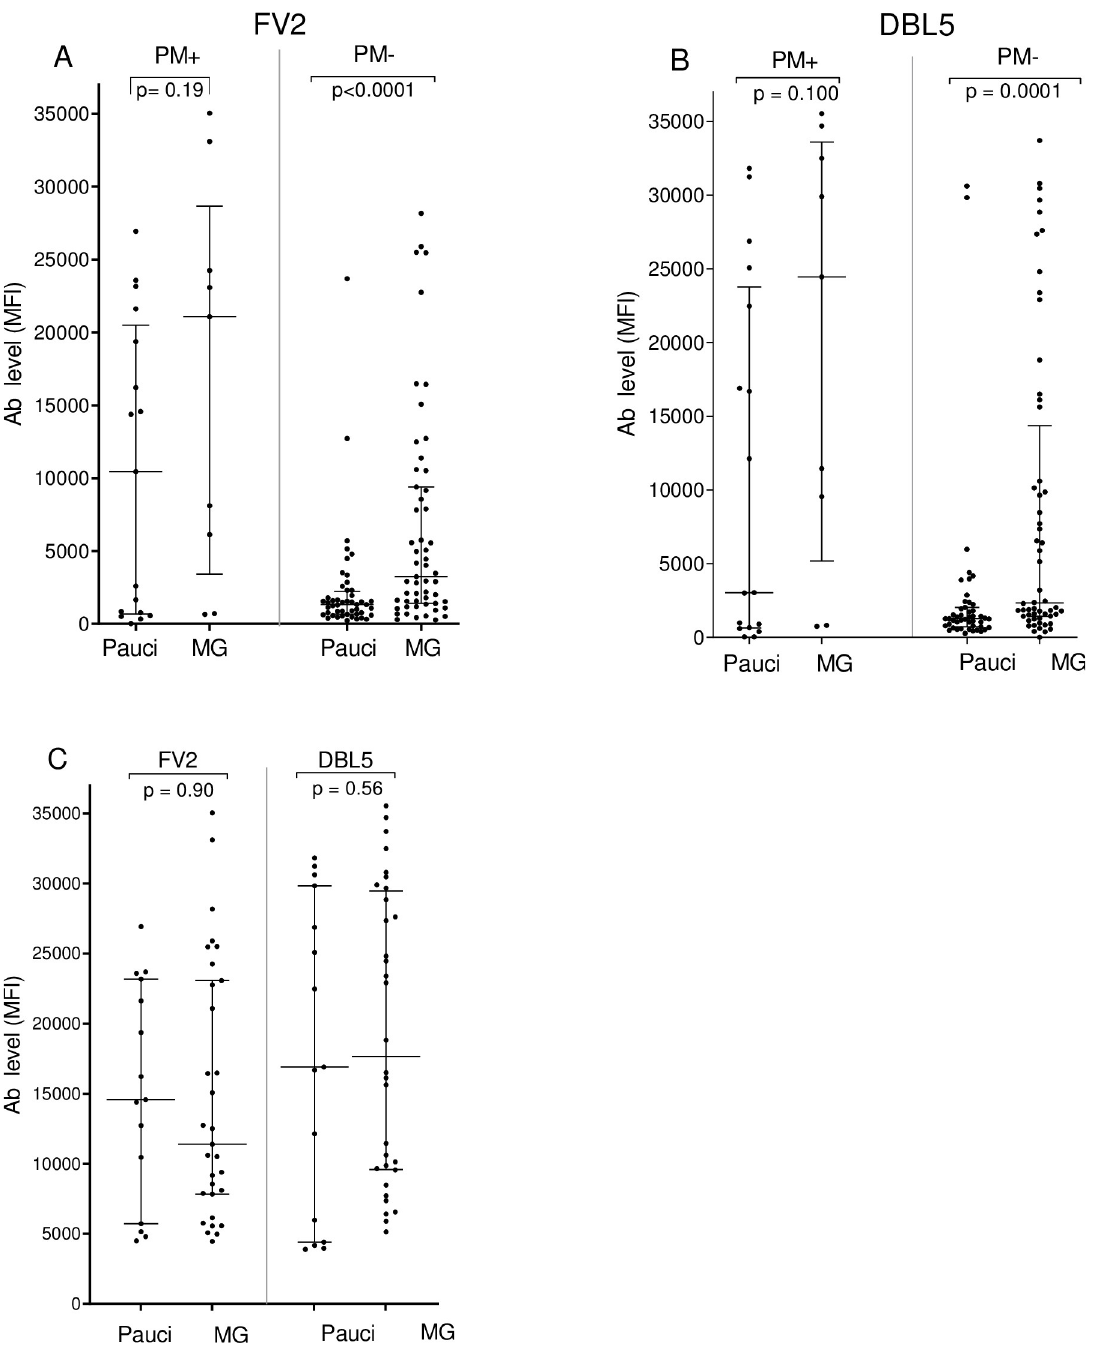
Fig 2. Antibody levels to VAR2CSA (FV2 and DBL5) in paucigravid and multigravid women. Plasma levels of Ab to VAR2CSA were compared between paucigravidae and multigravidae using the Mann-Whitney Rank Sum test. A and B: IgG Ab levels for all women (n = 130); C: IgG levels for women with Ab levels higher than the cut-off (i.e., results for only Ab+ women) (n = 49 women for FV2, n = 47 women for DBL5); MFI: median fluorescent intensity; IQR: interquartile range; Pauci: Paucigravid women; MG: Multigravid women; Ab: antibody; Cut-off for Ab-positive was 4,483 MFI for FV2 and 3,232 MFI for DBL5. Horizontal bars represent the group median +/- 25% IQR.